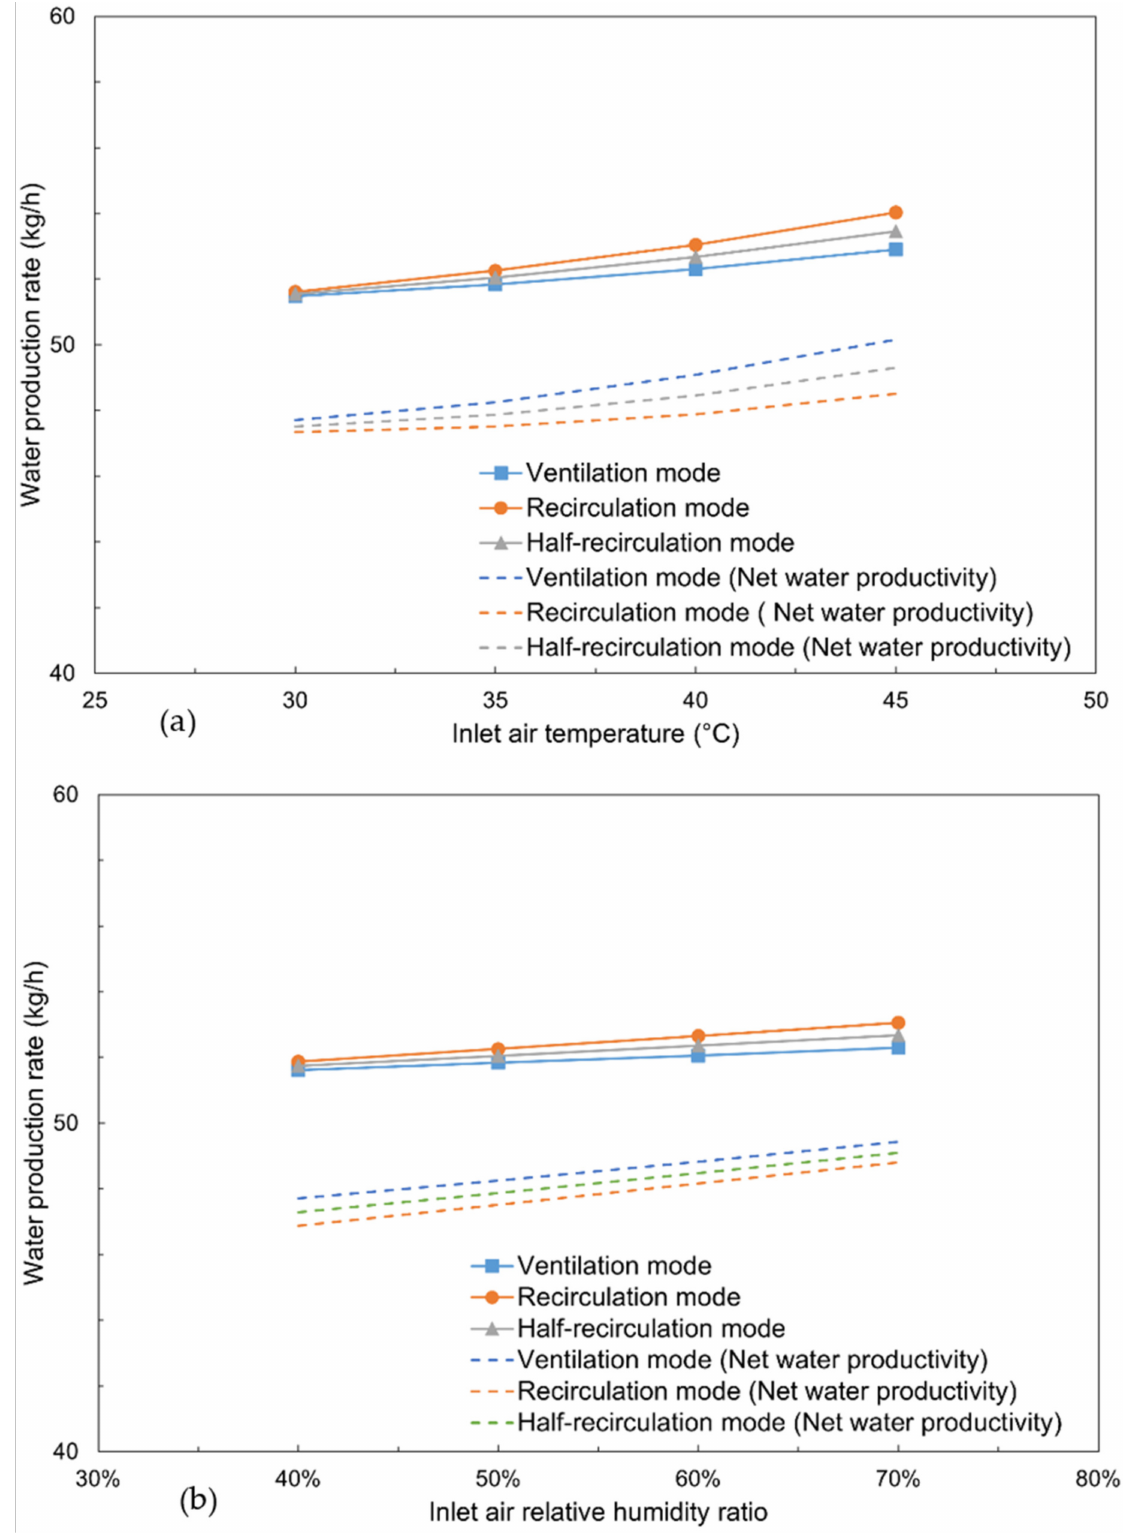
Figure 9. Effects of outdoor air ( a ) temperature and ( b ) humidity on water